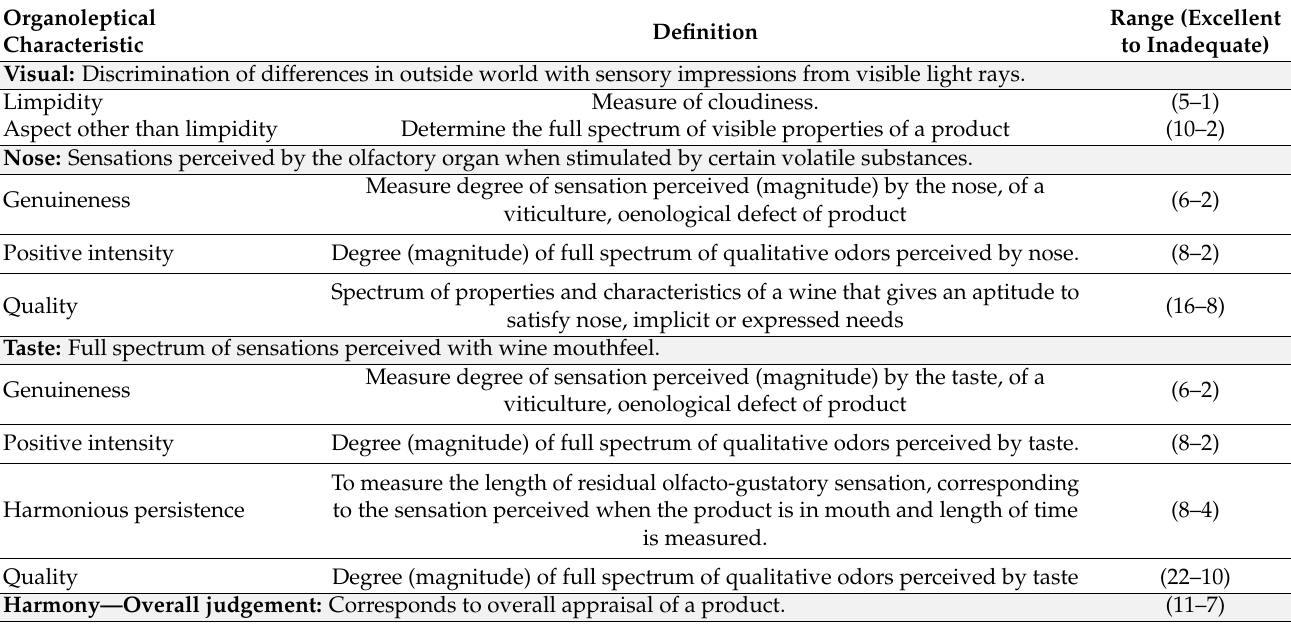
Table 1. Organoleptical characteristic and definition in sensory evaluation.